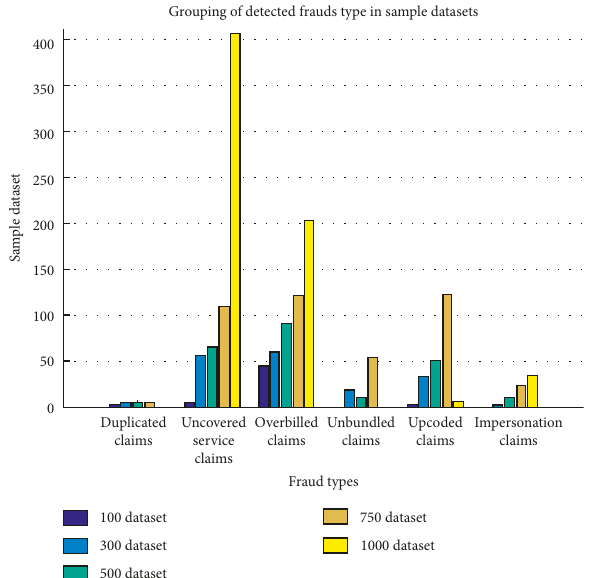
Figure 10: Fraud type distribution on the sample data sizes.